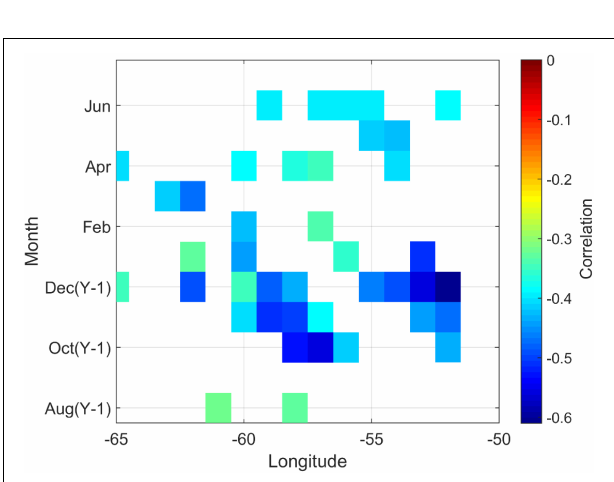
FIGURE 6 | Significant correlations ( p < 0.05) between A. islandica growth rate in SPM and SSF latitudinal position August (Y-1) and June